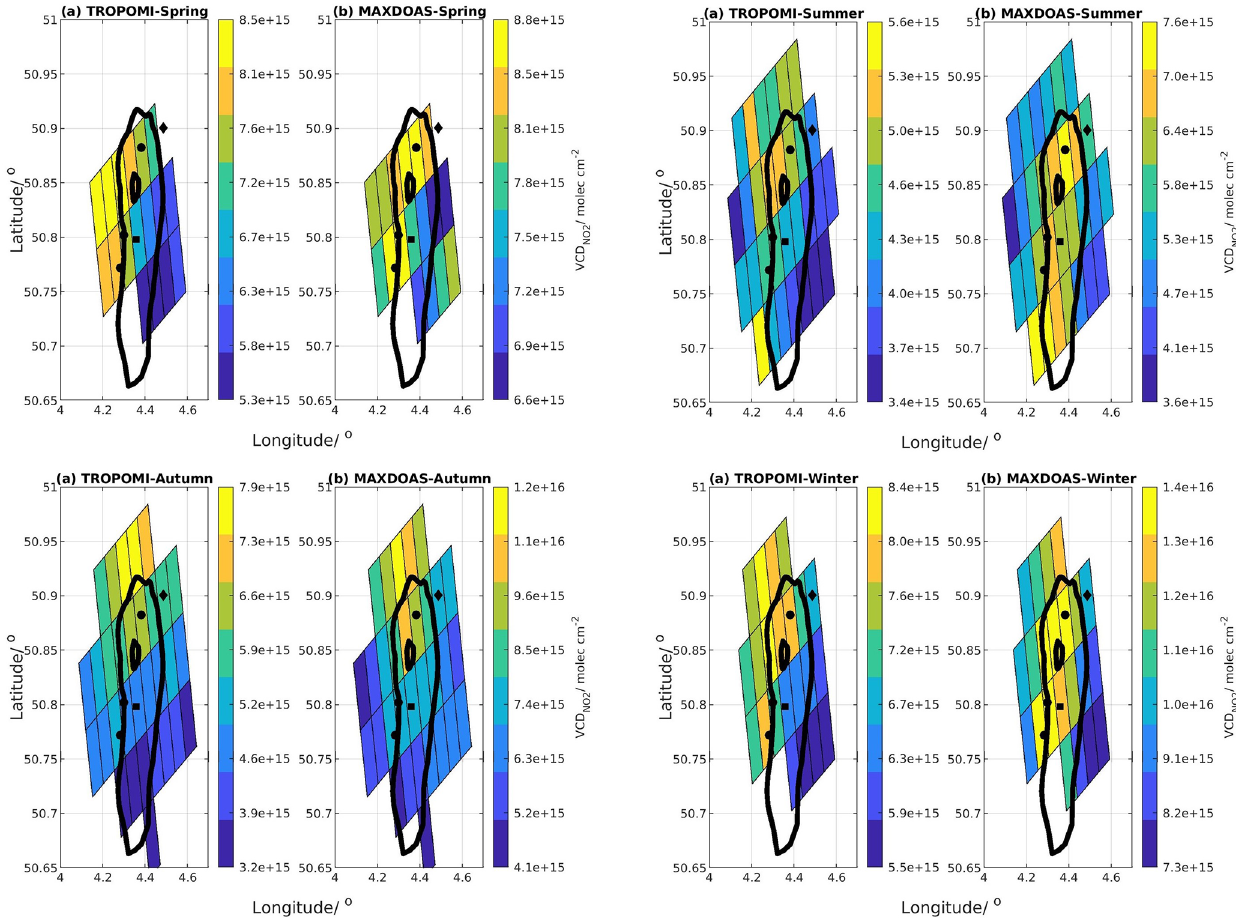
Figure 21. Seasonal tropospheric NO 2 VCD grids (TROPOMI grids) as retrieved over Brussels by TROPOMI and MAX-DOAS. The black square shows the MAX-DOAS position, the black polygon the national airport, the black dots the NO 2 hotspots, and the black line the Brussels Ring